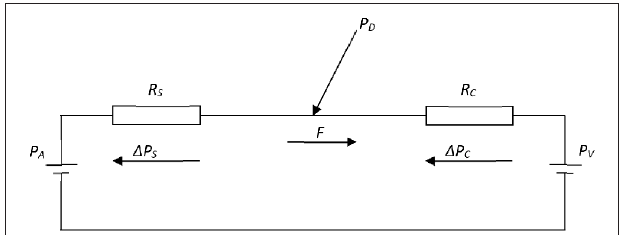
FIGURE 1 | Electrical analog of the coronary circulation. The model consists of an aortic pressure P A and a venous pressure P V with two resistances, serially connected between these pressure sources, to represent the stenotic R S and capillary R C fluid resistances. F is the flow through the resistances, while 1 P S and 1 P C are the pressure drops over the resistances R S and R C , respectively. P D is the pressure distal to the stenosis and proximal to the